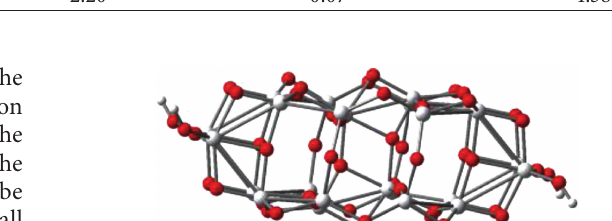
HOMO 9.48 0.99 1.82 LUMO 1.99 0.02 HOMO 8.21 0.84 LUMO HOMO HOMO LUMO HOMO LUMO